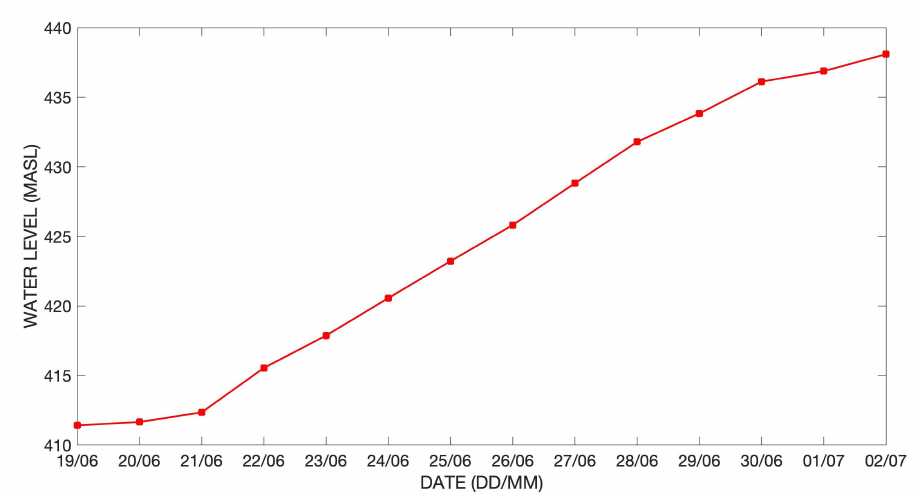
Figure 9. An example of processed water level data (converted from barometric data) from GLOF buoy B used to monitor water level in Lake Hullet. The example data covers the period from 19 June 2019 to 2 July 2019.